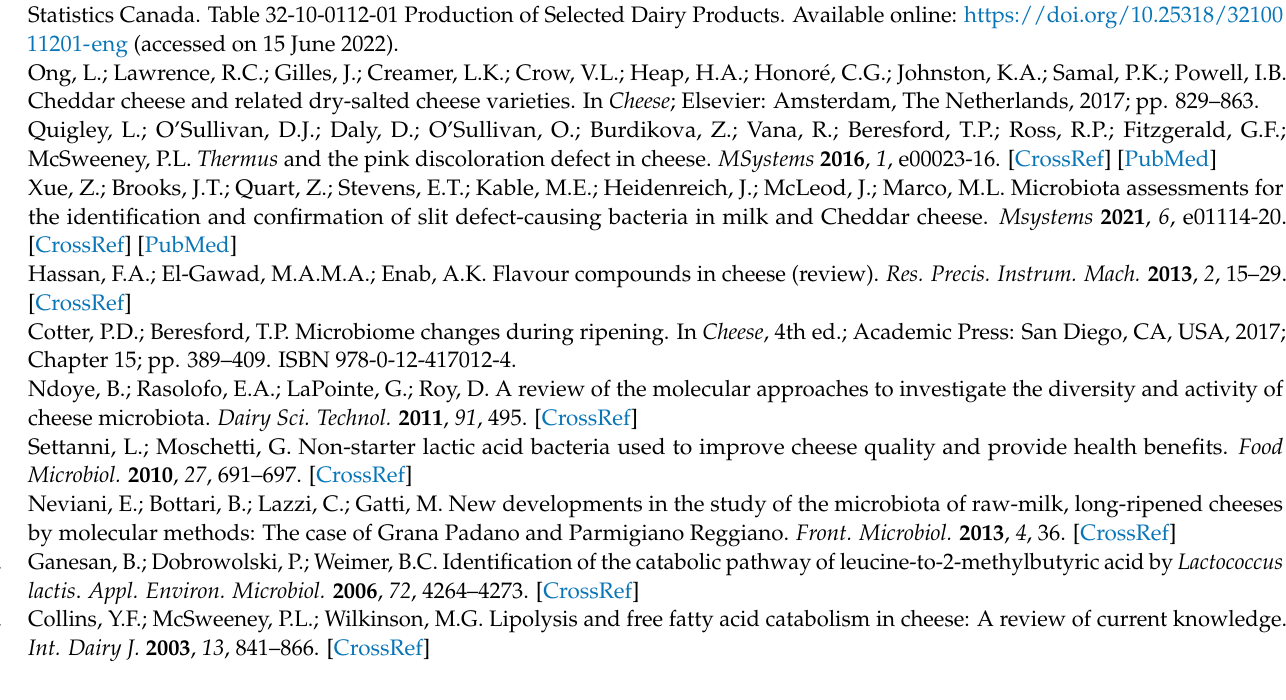
making trials were conducted over the course of 32 m. Figure S2. Average viable counts (log cfu/g cheese) of SLAB plated on GM17 agar for the two starters used in each of 13 trials over a maximum of 32 months of ripening. Figure S3. Average counts (log cfu/g cheese) on (a) GM17 agar to select for SLAB and (b) MRSv agar to select for NSLAB for 13 trials over a maximum of 32 m of ripening. Table S1. Average viable counts of microbial groups plated on GM17 agar to select for SLAB and MRSv for NSLAB over a maximum of 32 months of ripening for 13 trials. Table S2. Average 16S rRNA log gene copy number of specific target bacterial genera per g of cheese from total and viable cells in cheese samples from five trials measured by qPCR during 32 months of ripening. Table S3. Average relative abundance of Lactococcus spp. and NSLAB using 16S rRNA gene amplicon sequencing (% of total reads identified to genus level). Table S4. Average relative abundance of Lactococcus spp. using 16S rRNA gene amplicon sequencing per trial (% of total reads identified to genus level) over a maximum of 32 months of ripening. Table S5. Average relative abundance of NSLAB using 16S rRNA gene amplicon sequencing per trial (% of total reads identified to genus level per trial) over a maximum of 32 months of ripening. Table S6. Number of ASVs. Table S7. Total number of ASVs for Lactococcus spp. and Lacticaseibacillus spp. across 13 trials. Table S8. Number of ASVs for Lactococcus spp. and Lacticaseibacillus spp. for each of 13